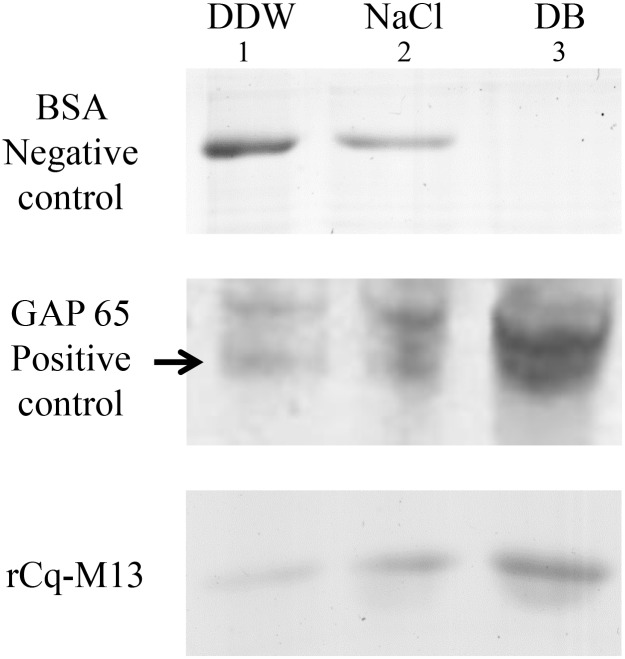
Chitin-binding ability of rCq-M13.Following incubation with chitin powder, equal amounts of Negative control—BSA (top), Positive control—GAP 65 (middle, using gastrolith protein extract with known chitin binding abilities [2], and rCq-M13 (bottom) underwent three consecutive washes prior to SDS-PAGE. Lane 1 represent the first wash with DDW, lane 2 represent the second wash with NaCl (0.2 M) and lane 3 represent the third wash with denaturation buffer (DB, containing SDS and 2-mercaptoethanol).